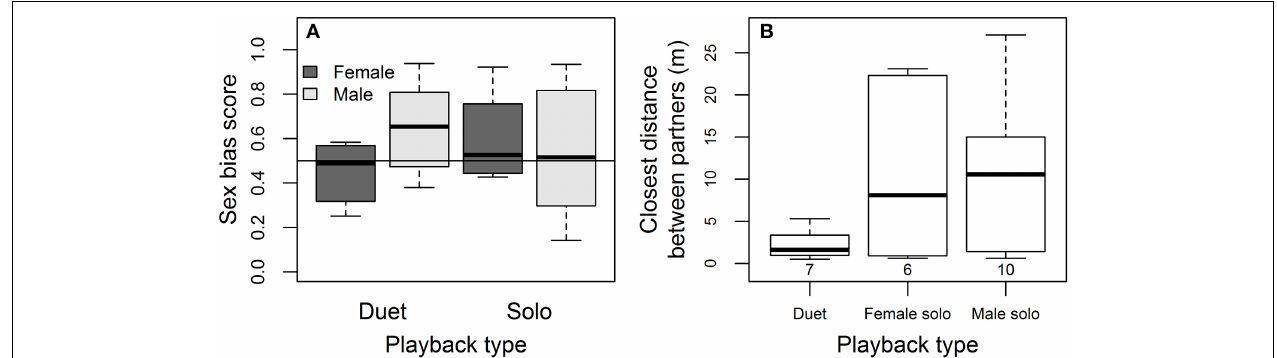
FIGURE 6 | Sex-specificity and coordination of approach to playback. (A) Sex bias in female and male approach during duet playback (male and female songs played simultaneously, simulating pair intrusion) and during solo playback (when male and female songs played on different days, simulating intrusion by solitary birds). The line at 0.5 indicates equally close approaches to same- and opposite-sex playback, while